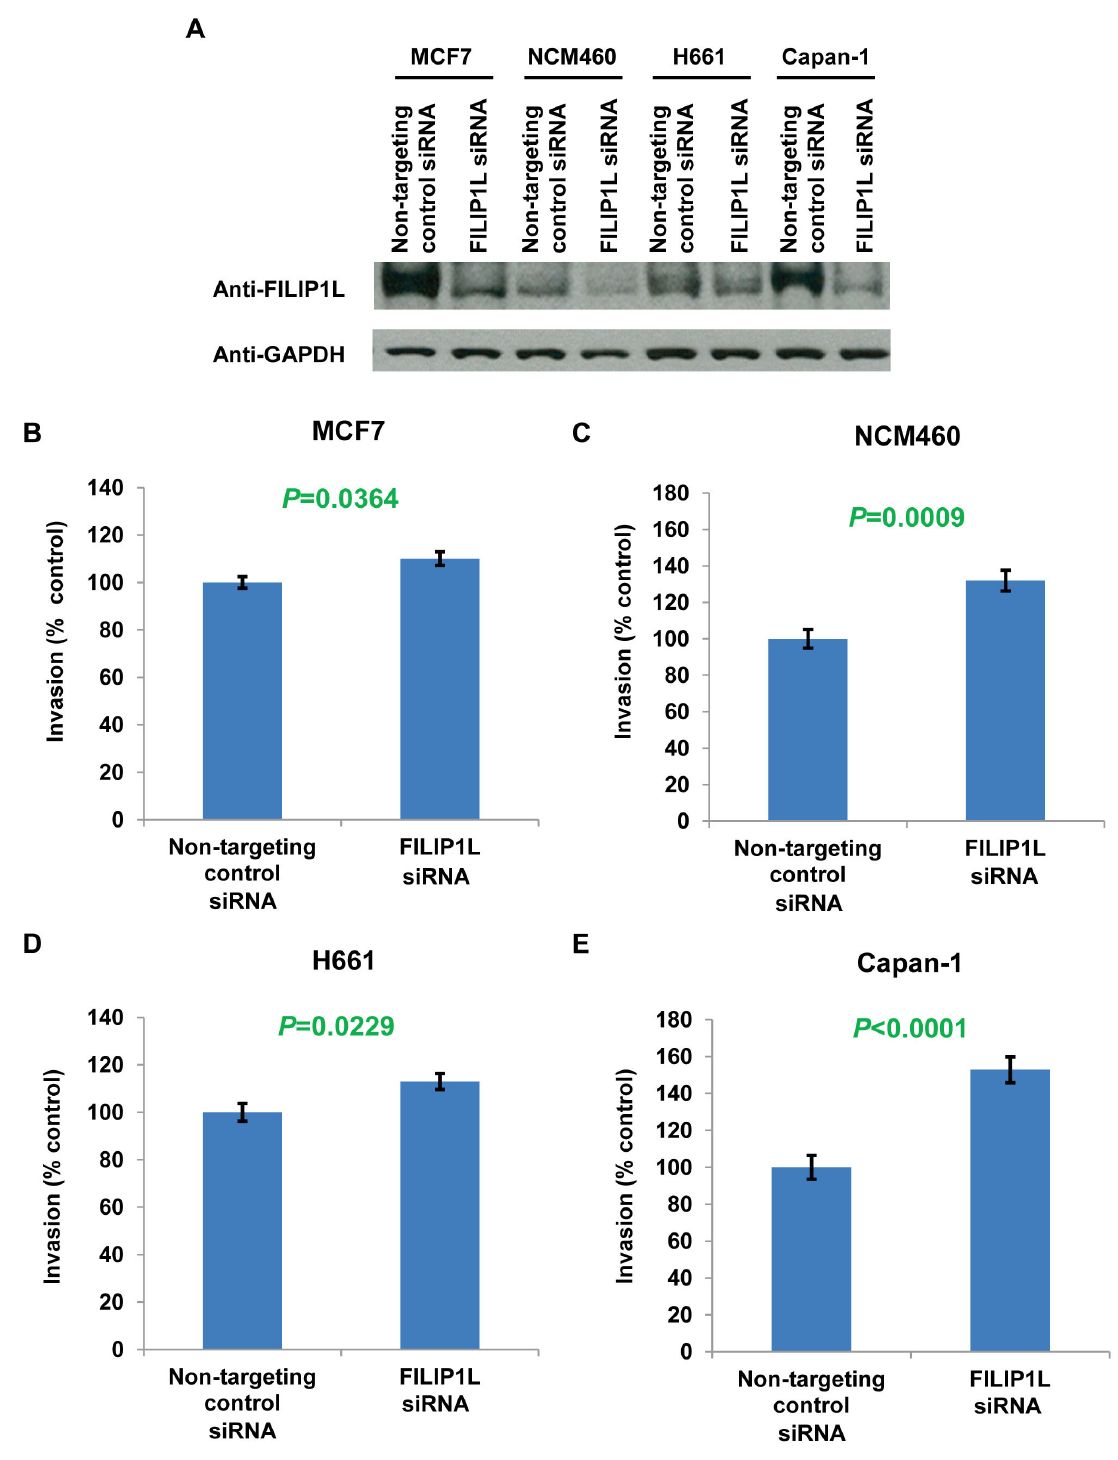
Figure 8. Increase of cell invasion following FILIP1L knockdown in various FILIP1L-high-expressing, low-invasive cancer cell lines. MCF7 breast ( B ), NCM460 colon ( C ), H661 lung ( D ) and Capan-1 pancreatic ( E ) cancer cell lines were transfected with either non-targeting or FILIP1L siRNA. A , Immunoblot analysis for FILIP1L in the transfected cells. GAPDH blot is shown as the loading control. B - E , Transfected cells were subject to Matrigel cell invasion assay 48 h after transfection. The same experimental procedures were followed as described in Figure 6. The result is representative of two independent experiments. doi: